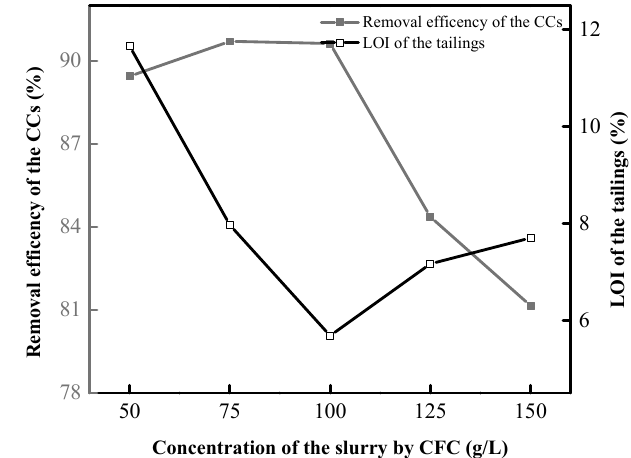
Figure 9. Effect of the slurry concentration on decarburization by CFC: kerosene = 3 g/kg·ash, MIBC = 0.1 g/kg·ash, Tween 80 = 5% of the kerosene dosage, and impeller speed = 2000 r/min.